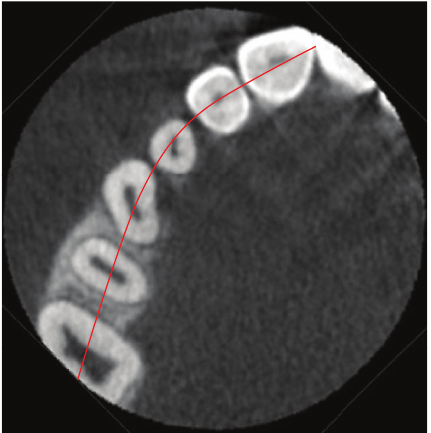
Figure 4: Occlusal reference arch (𝑧) ; axial view. In this example